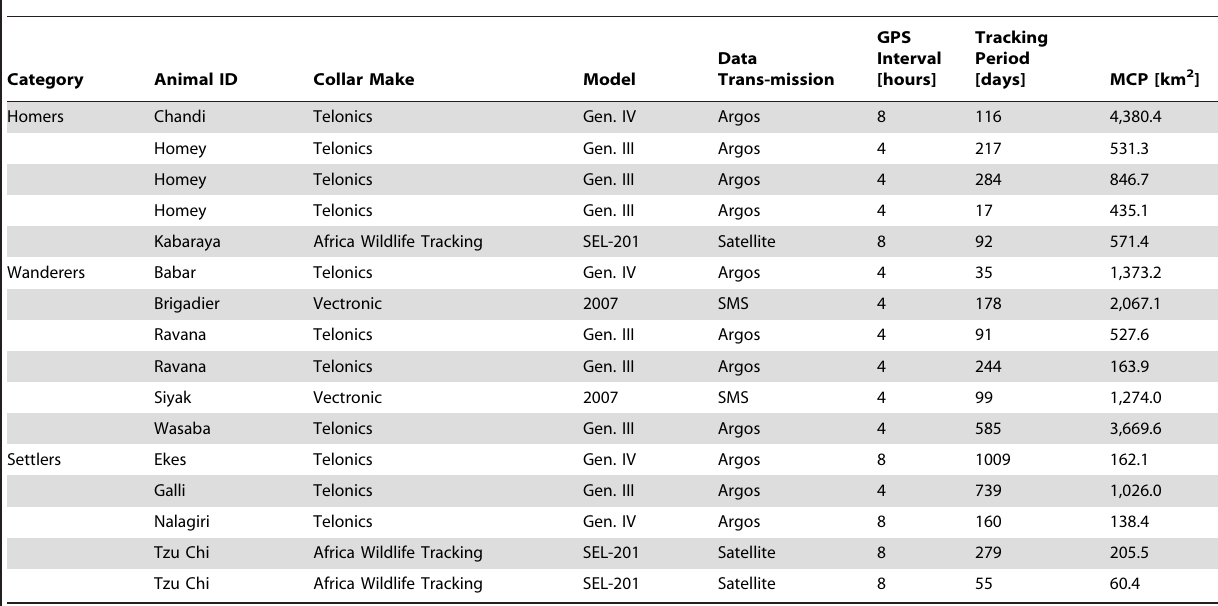
Table 1. Details of collars, programming and use-area (MCP) for the translocated elephants.